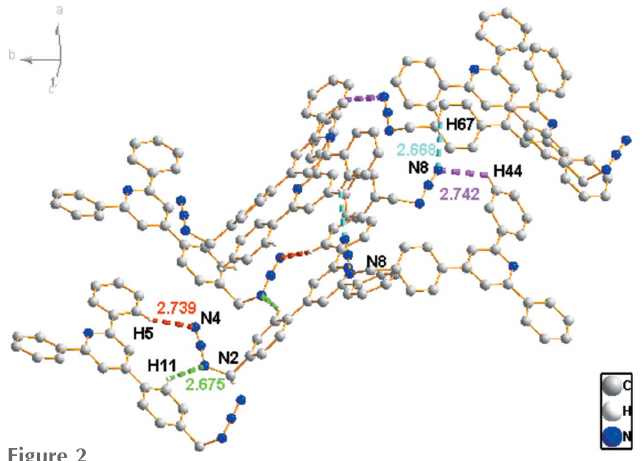
Figure 2 Partial packing diagram of the title compound. Some short C—H (cid:2)(cid:2)(cid:2) N contacts are indicated by dashed